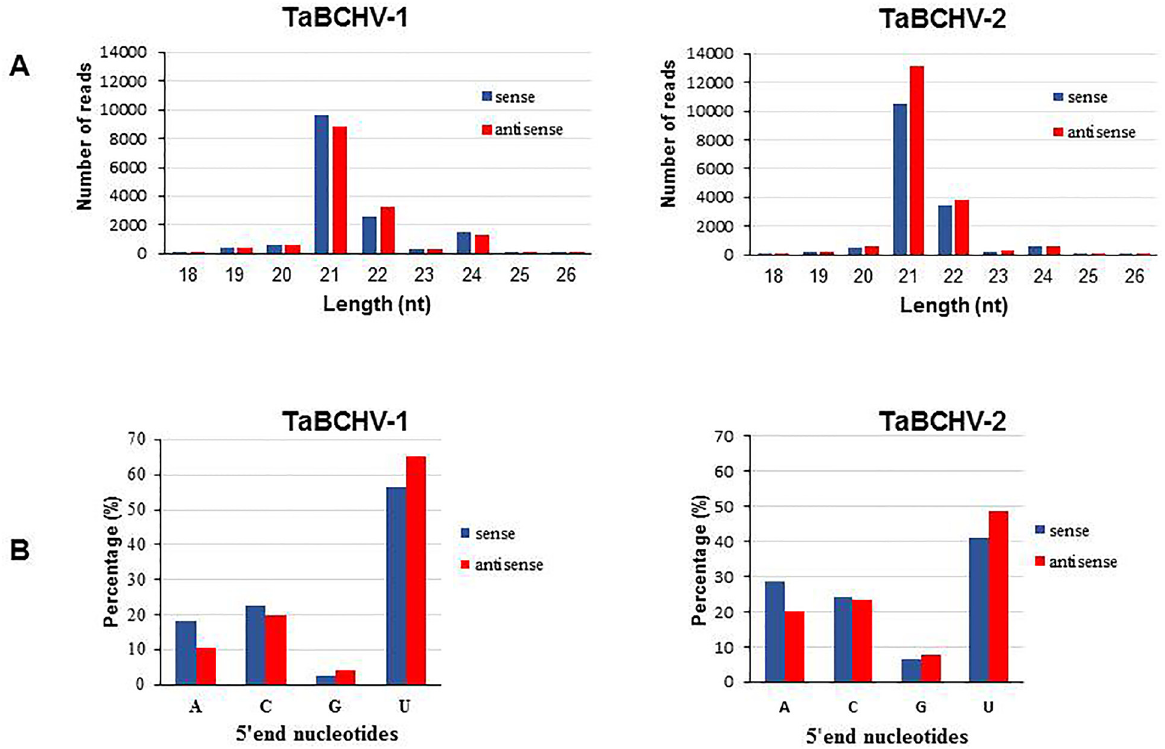
Fig 4. Size distribution of vsRNAs derived from TaBCHV-1 and TaBCHV-2 (A) and the relative frequency of 5' terminal nucleotide of 21- and 22-nt vsRNA (B). Blue and red bars indicate sense and antisense vsRNAs respectively.